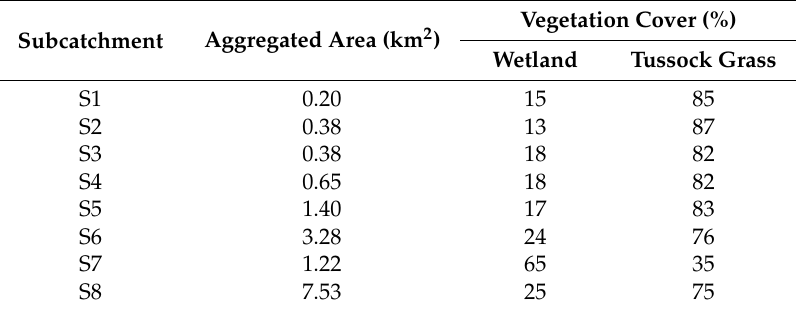
Table 1. Subcatchment aggregated area and vegetation